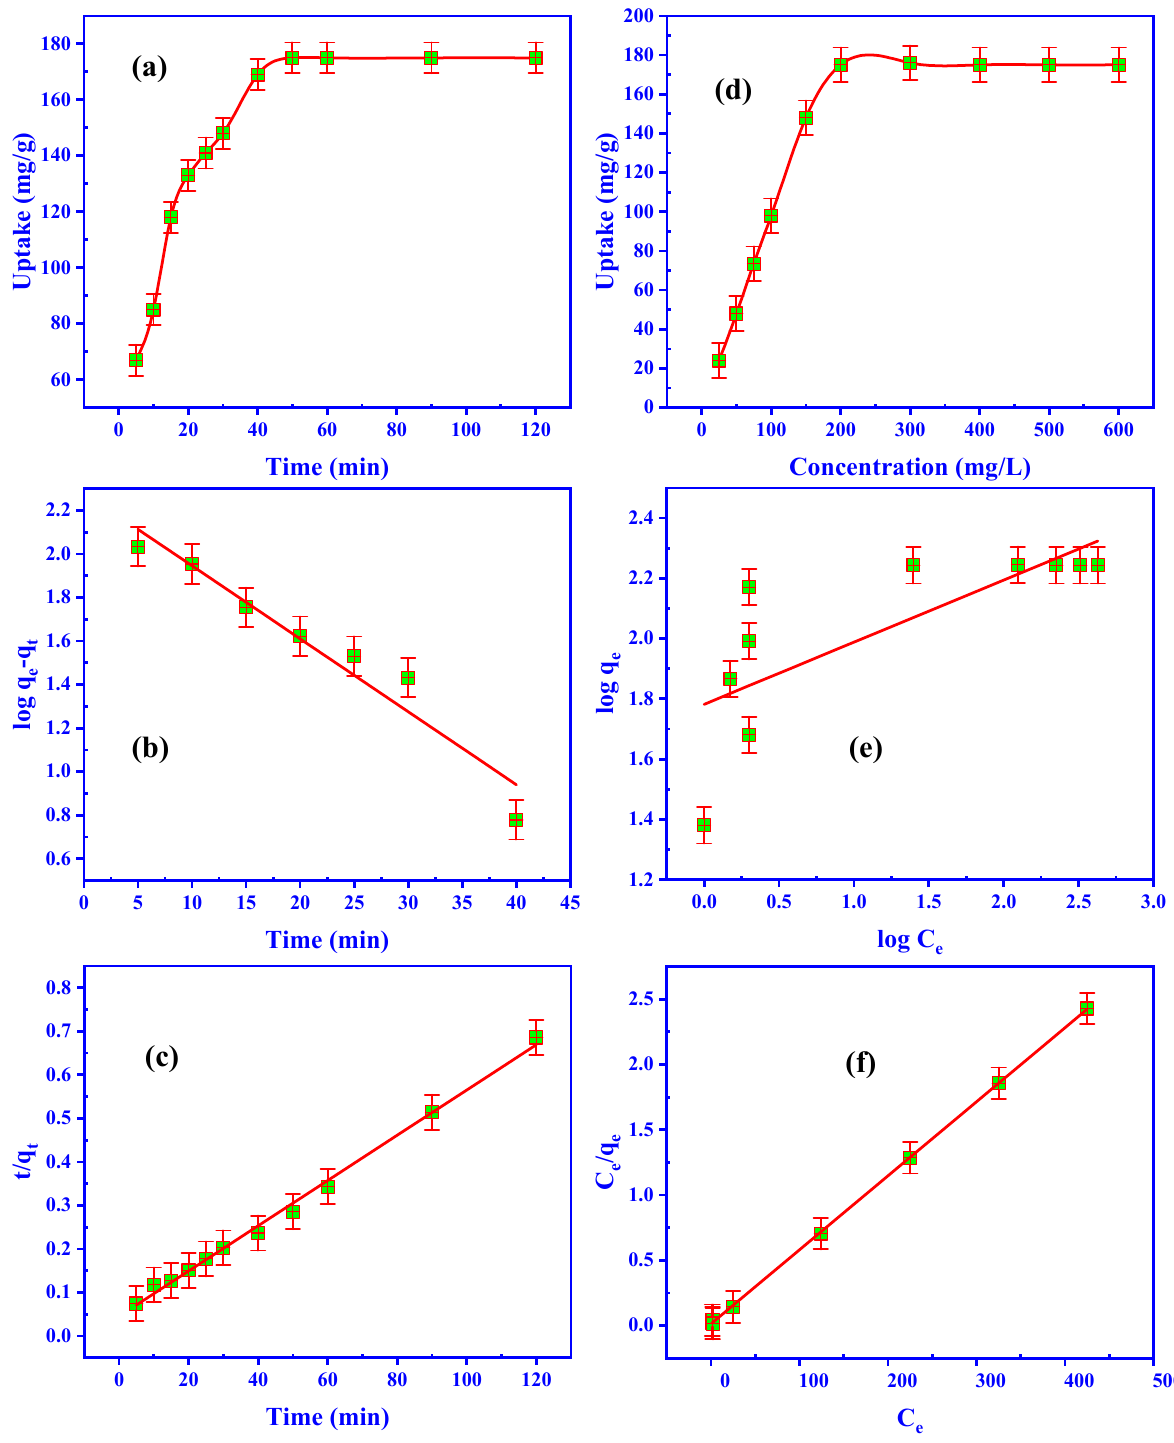
Figure 7. Influence of ( a ) adsorbing time, ( b ) 1st-order kinetic, ( c ) 2nd-order kinetic, ( d ) U(VI) concentration, ( e ) Freundlich isotherm, ( f ) Langmuir isotherm on the adsorption efficiency of U(VI) using ZrO 2 /CS.